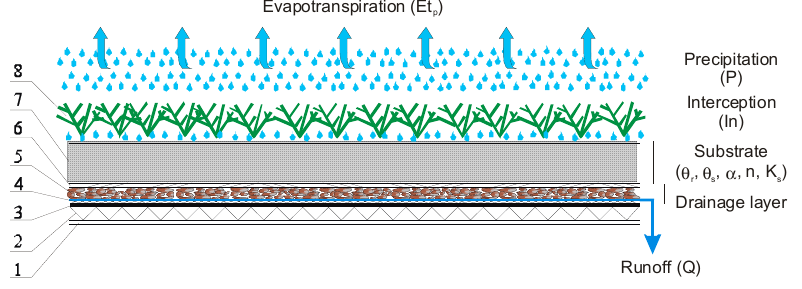
Figure 1. Construction details of extensive type green roof, substrate with pumice or zeolite, physically based model. 1—model support structure, 2—thermal insulation—extruded polystyrene (XPS), 3—water proofing membrane, 4—geotextile type RMS 300 (absorptive-protective), 5—gravel layer, granulation from 1 to 2 cm, 6—filtration geotextile, 7—substrate with pumice or zeolite, 8—vegetation on the substrate layer—Sedum sexangulare, Sedum telephium, Sedum spurium, Sedum floriferum, Sedum album.